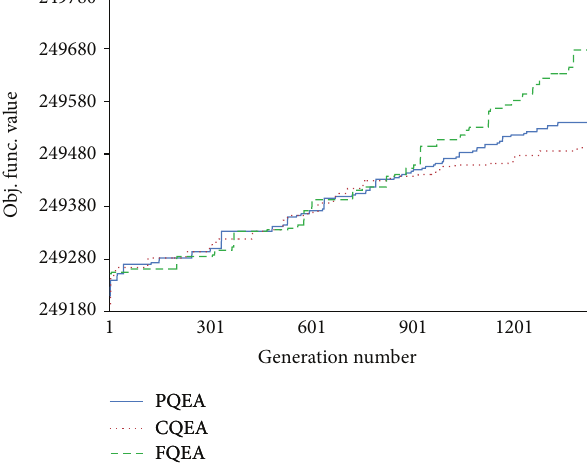
Figure 28: Convergence graph of PQEA, CQEA, and FQEA on 0-1 knapsack problem with profit ceiling data instances with number of items, 𝑀 , being 5000 and capacity, 𝐶 , being 10% of total